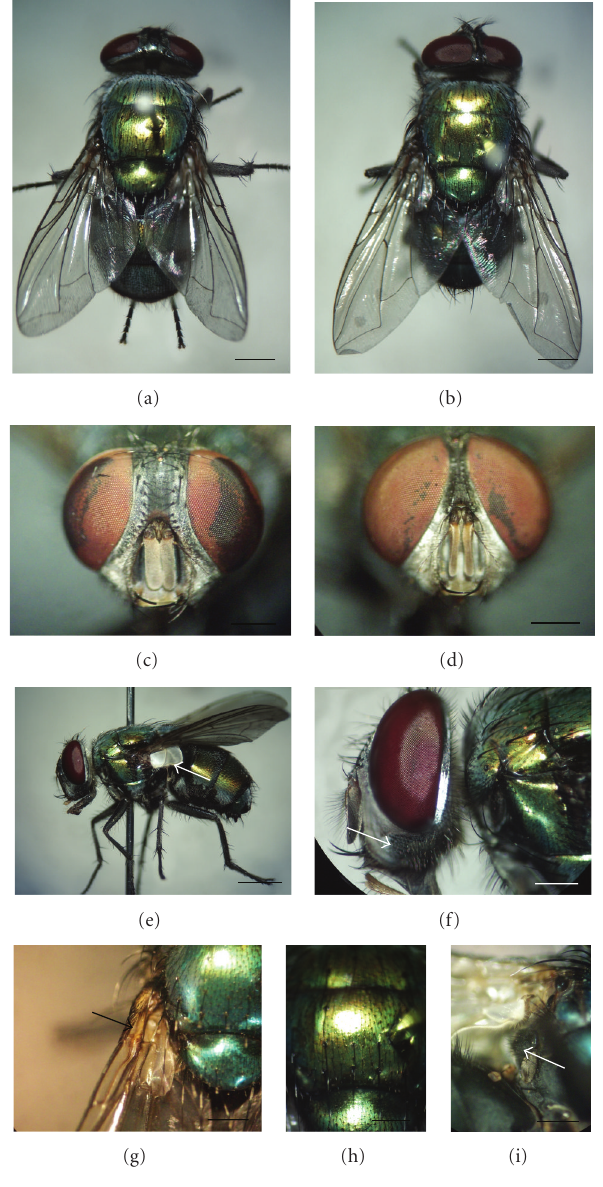
Figure 5: Adults and important characteristics for identification of Hemipyrellialigurrien . (a) Dorsal view of the female. (b) Dorsal view of the male. (c) Frons of the female showing dichoptic eyes. (d) Frons of the male showing subholoptic eyes. (e) Lateral view of the adult showing whitish squamae (arrow). (f) Higher magnification of the head showing black hairs on the gena (arrow). (g) Wing showing the stem vein without setulae (arrow). (h) Dorsal thorax. (i) Pilose hair on the supraconvexity (arrow). Bars = 200 µ m for all